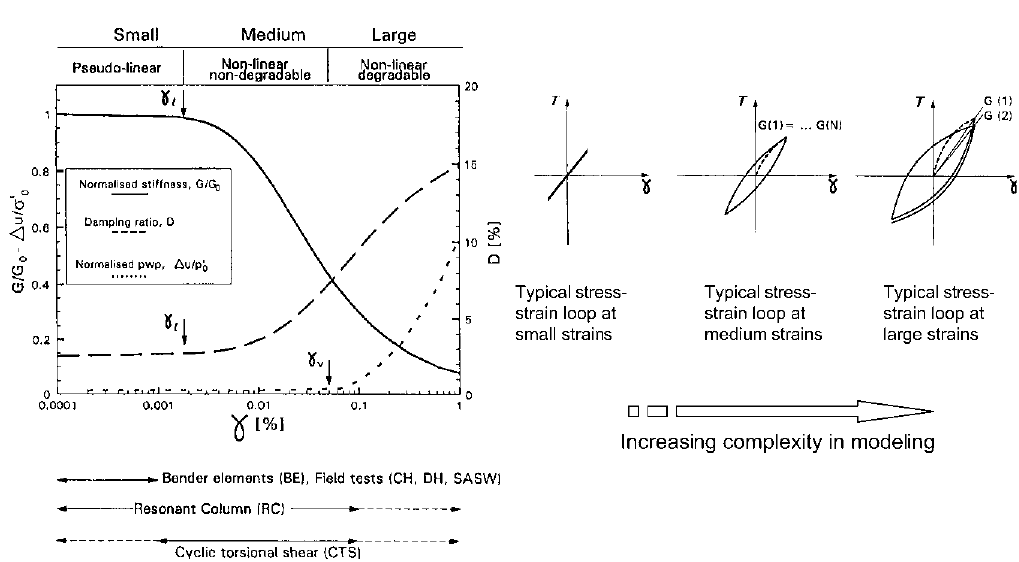
Fig. 2. Typical variation of the soil response under cyclic loading at increasing strain level in terms of shear modulus and damping and stress-strain